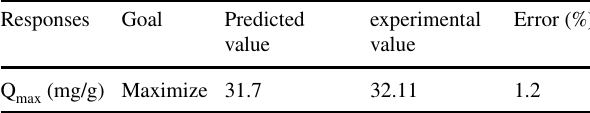
Table 10 Q max responses, predicted and experimental values